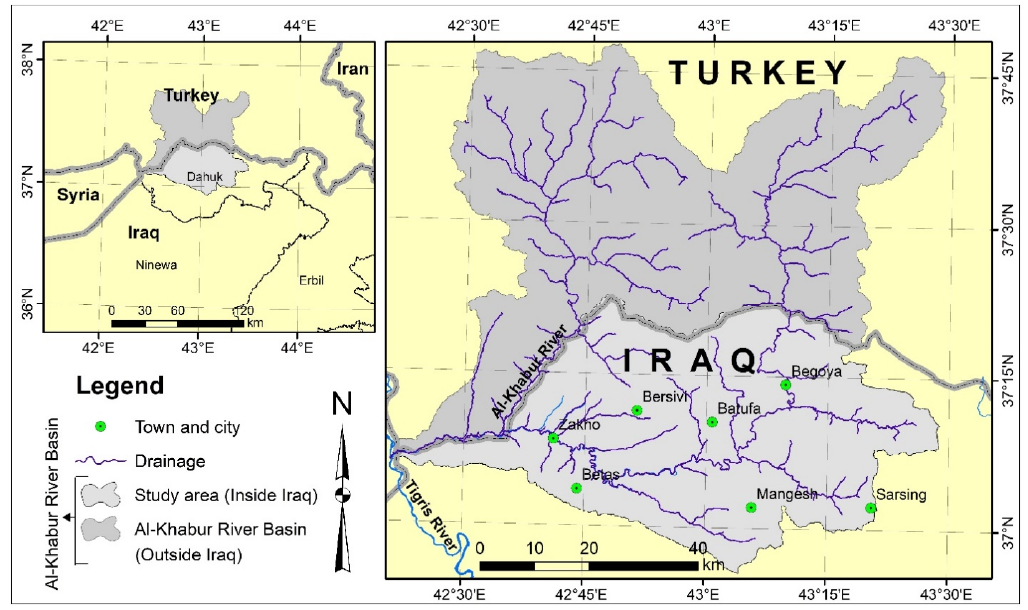
Figure 1. Location map of the Al-Khabur River Basin (KhRB).